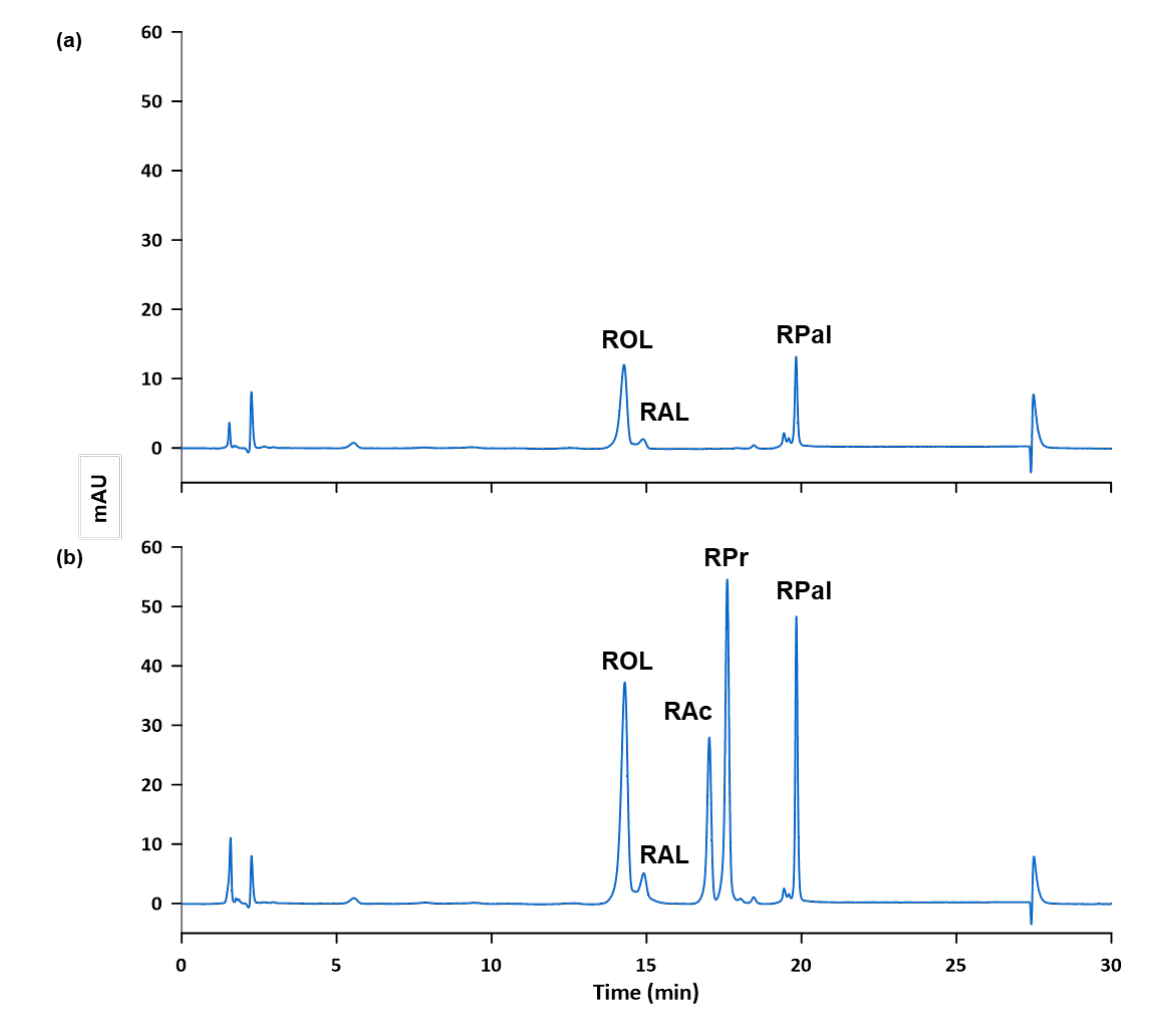
Figure 4. Chromatogram of sample S5 obtained according to the proposed method: ( a ) unfortified and ( b ) fortified at 4 µg mL −1 .